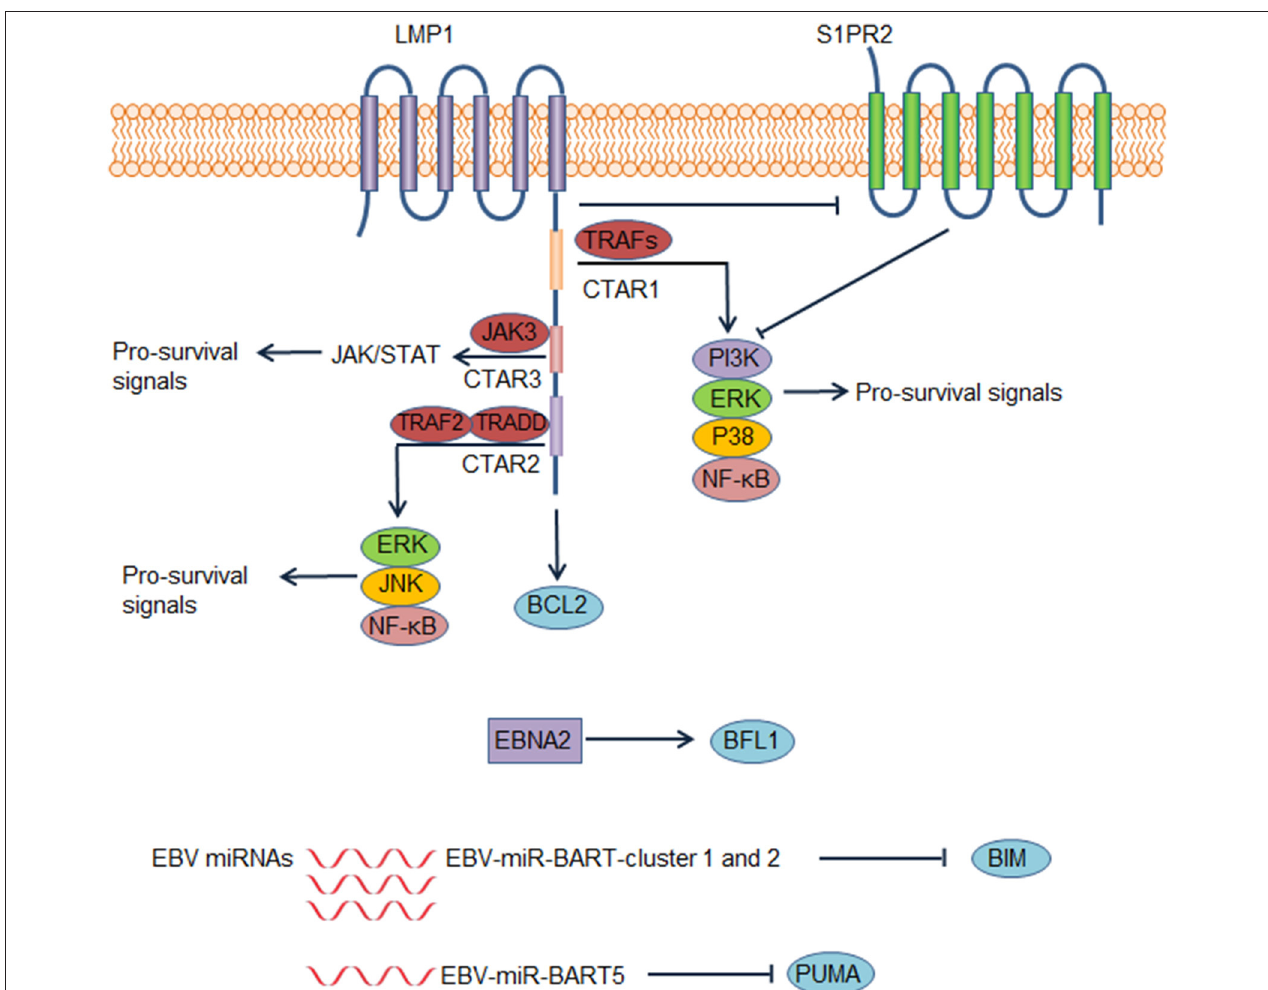
FIGURE 4 | Epstein-Barr virus (EBV) contributes to dysregulation of survival of diffuse large B cell lymphoma (DLBCL) cells. In EBV positive DLBCL, LMP1, EBV nuclear antigen 2 (EBNA2), and several EBV microRNAs could lead to abnormal survival of DLBCL cells, contributing to the pathogenesis of EBV positive DLBCL. These factors lead to enhanced survival of DLBCL cells by increasing pro-survival signals or suppressing pro-apoptotic proteins. Abbreviations: BART, Bam HI A region rightward transcript; CTAR, C-terminal activation region; TRADD, tumor necrosis factor receptor type 1–associated death domain; TRAF, tumor necrosis factor receptor associated